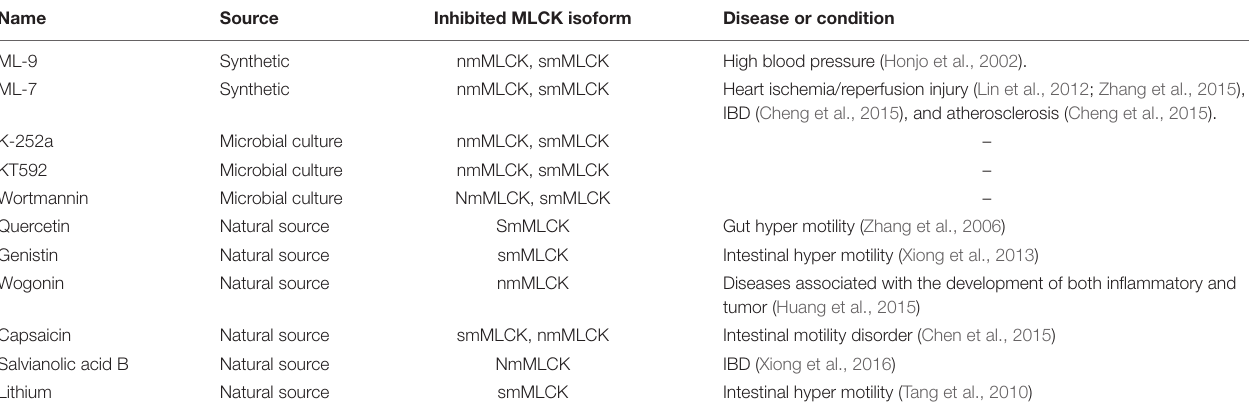
TABLE 2 | Myosin light chain kinase inhibitors with potential pharmaceutical use.